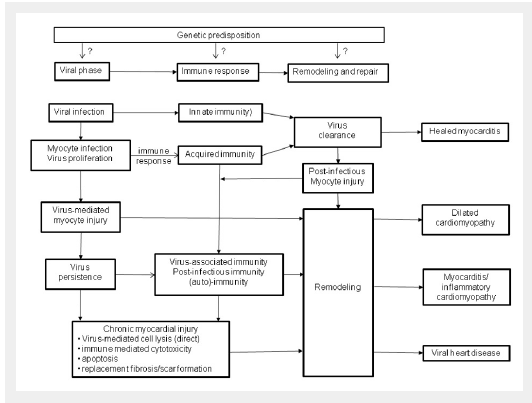
Three phase model of cardiovascular infection: A genetic predisposition is supposed (?) for some viruses but currently not proven. During the viral phase, infected cardiomyocytes become injured and the virus may persist due to an inadequate immune response. A regularly mounted immune response (phase 2) eliminates the viral infection and may further damage the myocardium if it declines improperly. Post-infectious, post- inflammatory immunity and preceding myocardial damage may stimulate ongoing tissue remodelling (phase 3) which affects cardiac function in the long run despite clearance of the initial